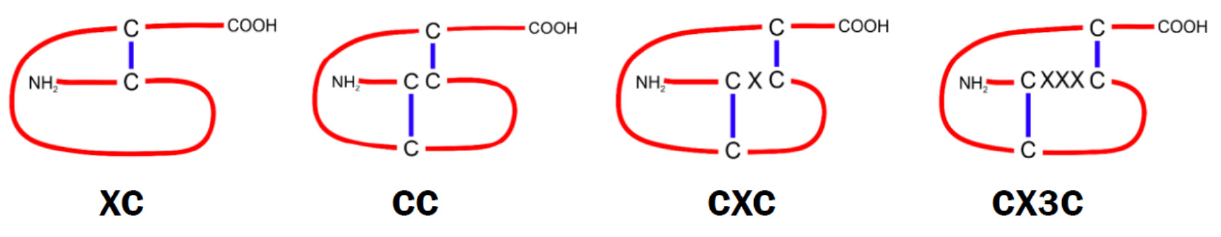
Figure 6. Schematic structures of chemokine subtypes.